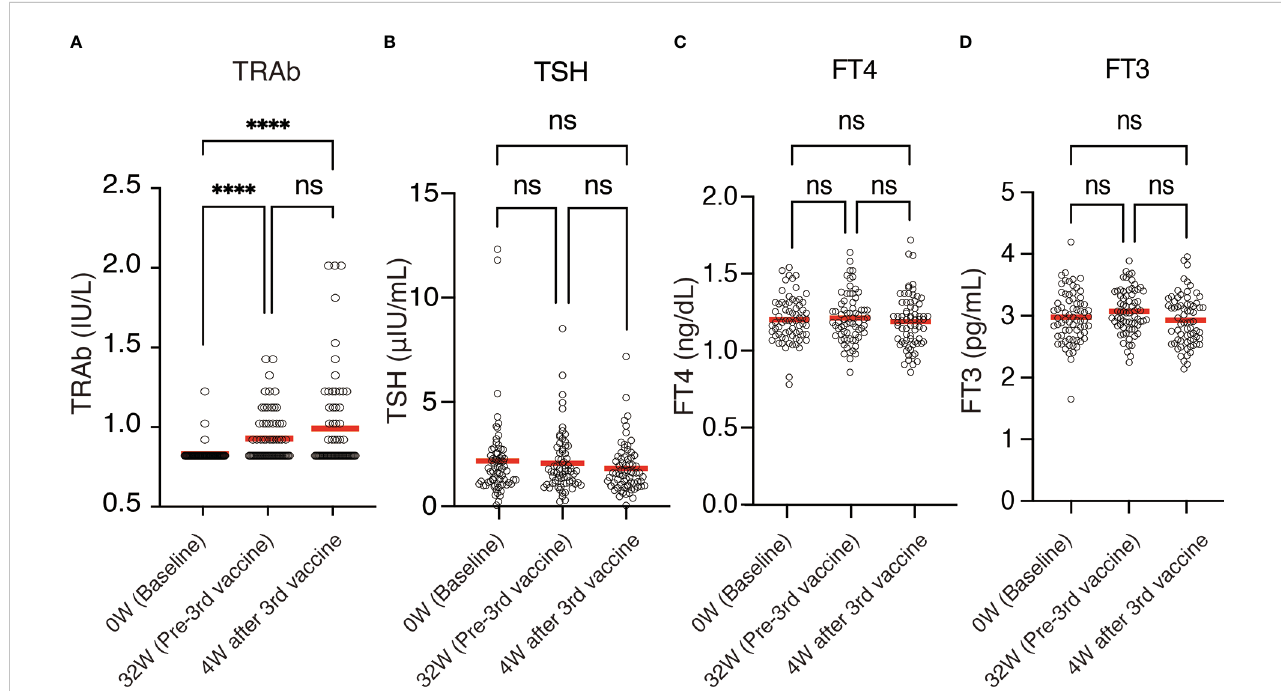
FIGURE 2 Time course of (A) TRAb, (B) TSH, (C) FT4, and (D) FT3 (n = 70). Each circle denotes individual values. Mean values were indicated by red bars. Mean values are also presented in Table 1. ns, not signi fi cant; **** P <